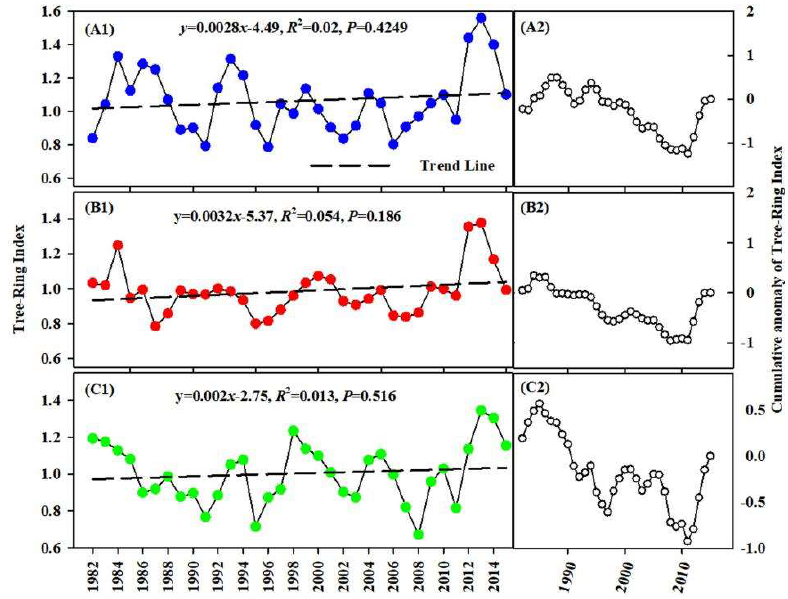
Figure 6. Interannual variation characteristics of TRW. Note: ( A1 , B1 , C1 ) show the annual change of TRW in alpine, valley and desert areas. Meanwhile, ( A2 , B2 , C2 ) show the change of cumulative anomaly of TRW in alpine, valley and desert areas.